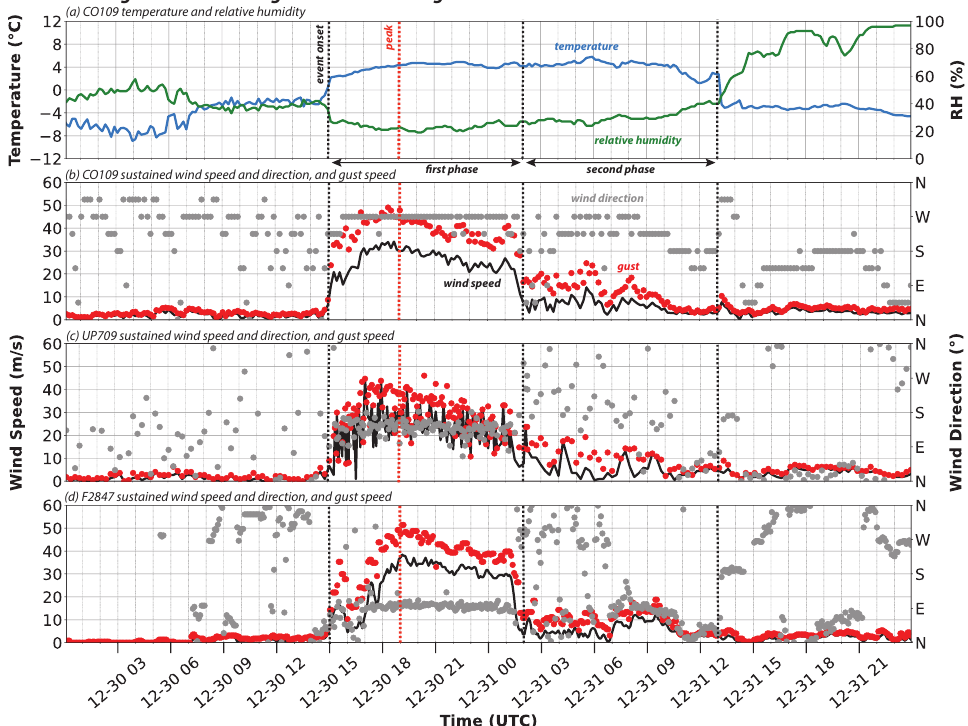
Figure 2. Meteograms from stations ( a , b ) CO109, ( c ) UP709, and ( d ) F2847. These stations are labeled on Figure 1. In ( a ), temperature is blue and relative humidity is in green. In ( b – d ), sustained wind speed is black, gust is red, and direction of the sustained wind is